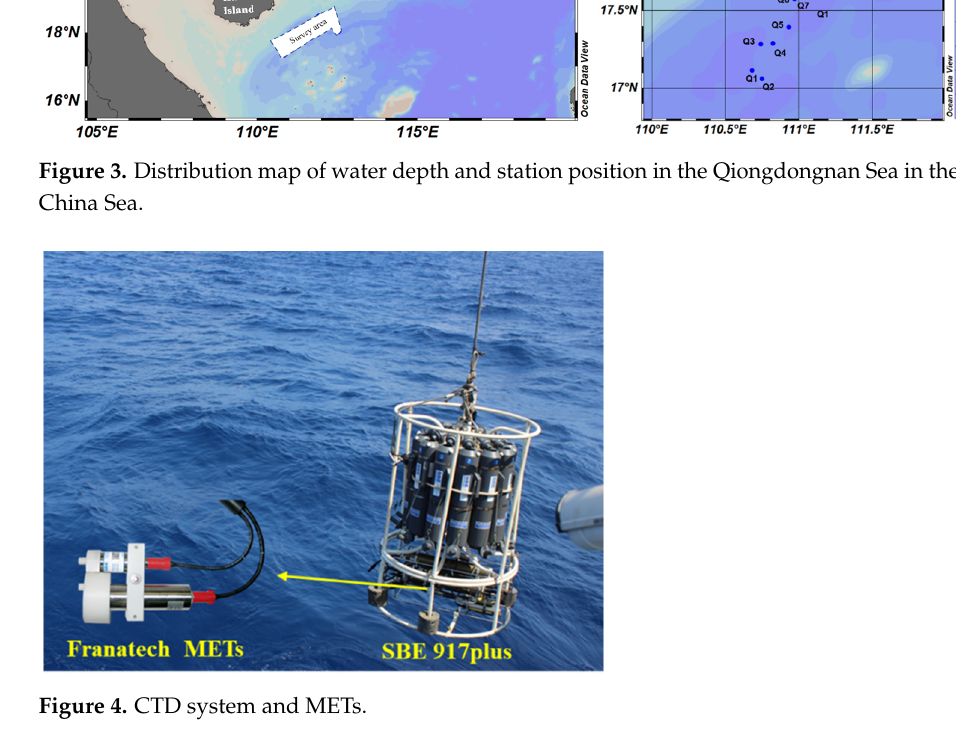
Figure 4. CTD system and METs.